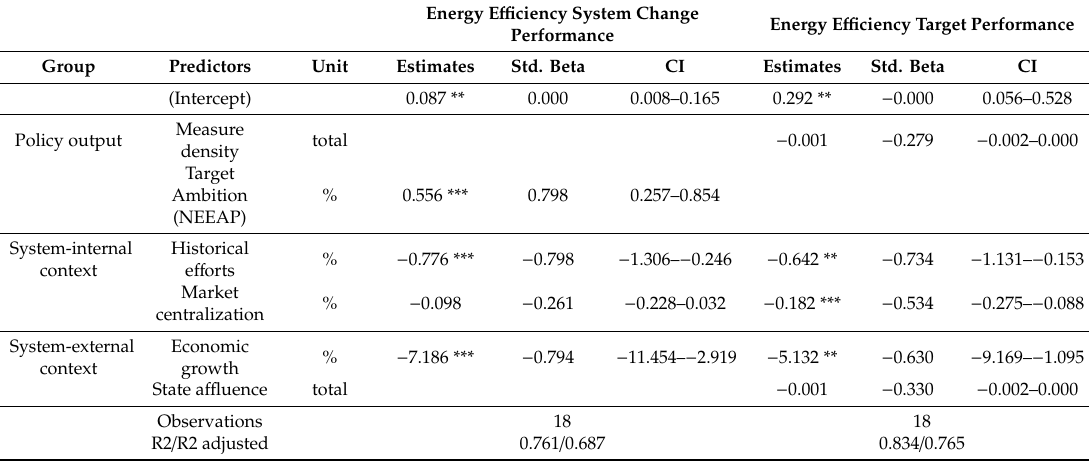
Table 4. Predictors for energy e ffi ciency performance (system change and target performance) estimates including 95% confidence